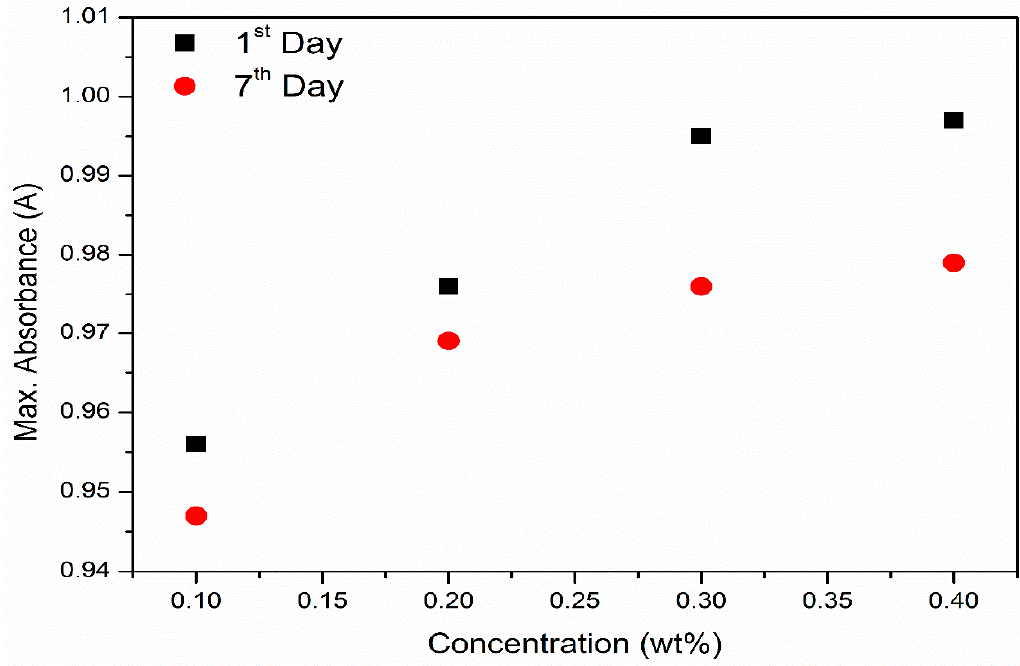
Figure 14. Absorbance analysis with respect to MXene concentration.